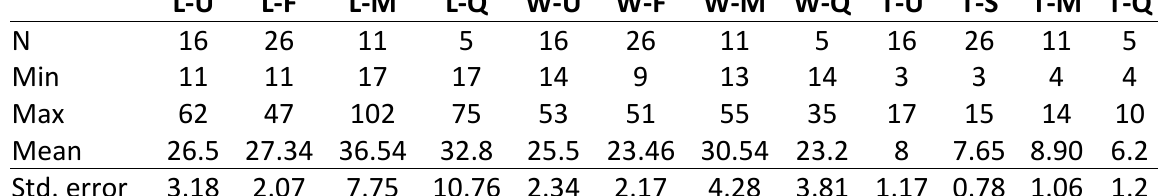
Table 3. Metric values (L: Length, W: Width, T: Thickness) of different raw materials (U: Urgonian flint; F: Non-Urgonian flint; M: Mudstone; Q: Quartzite).